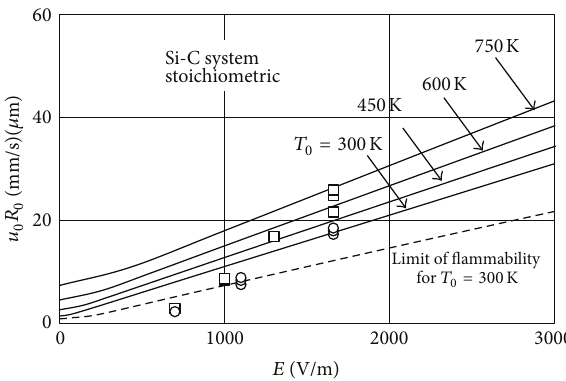
Figure 4: SHS rate-constant 𝑢 0 𝑅 0 as a function of the electric field 𝐸 , with the initial temperature 𝑇 0 taken as a parameter. Solid curves represent the state when there is no heat loss; a dashed curve represents the limit of flammability. Data points are experimental